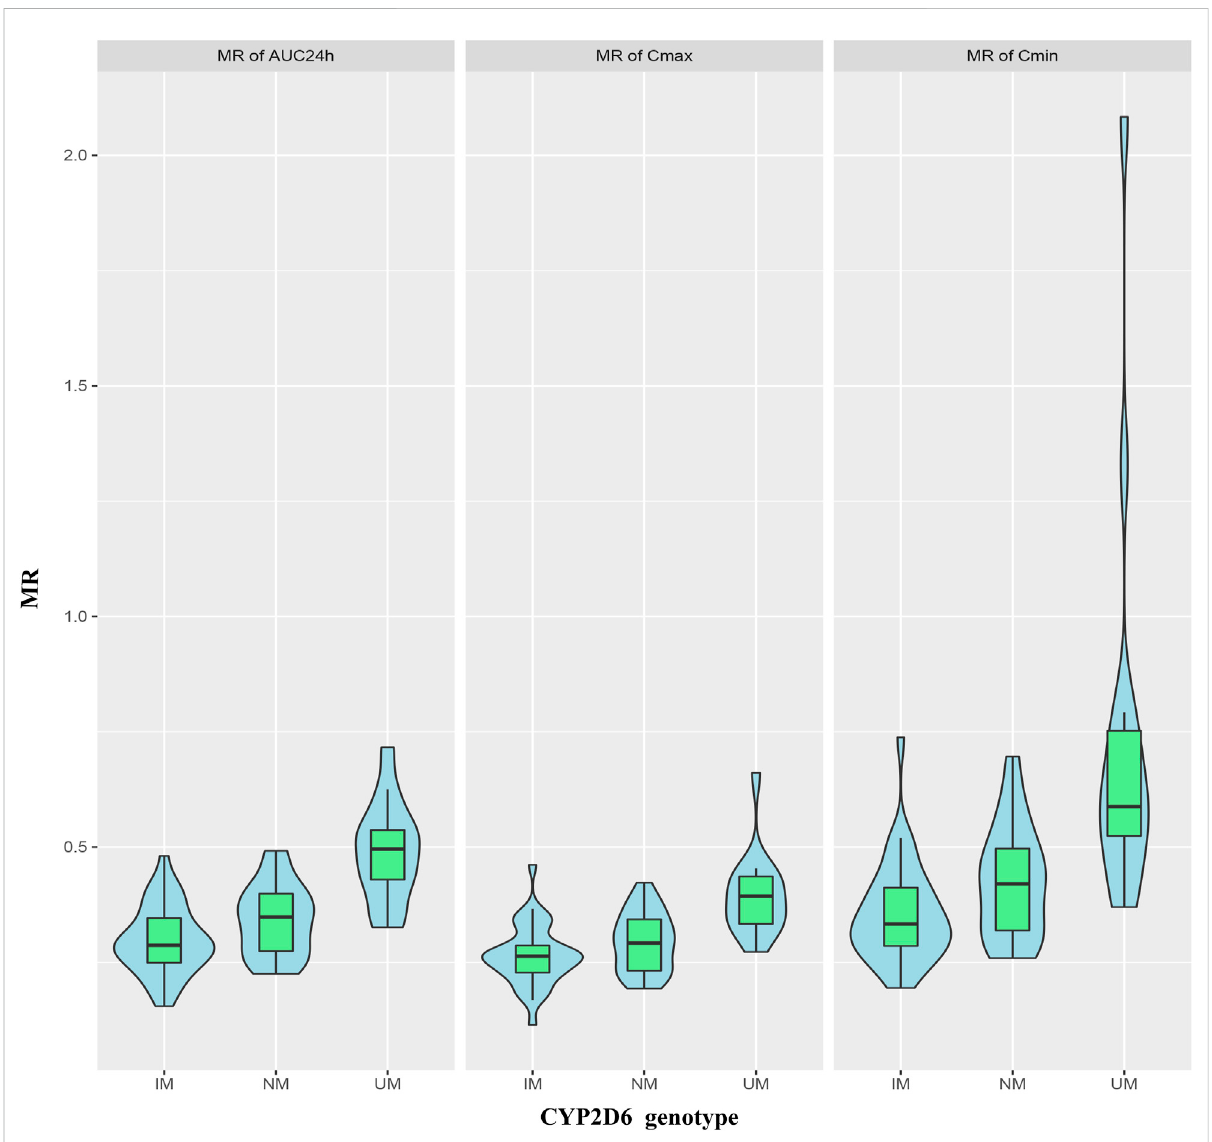
FIGURE 6 Violin pictures of DARI/ARI steady-state drug metabolic ratio (MR), including MR AUC24h , MR Cmin and MR Cmax , for IMs, NMs and